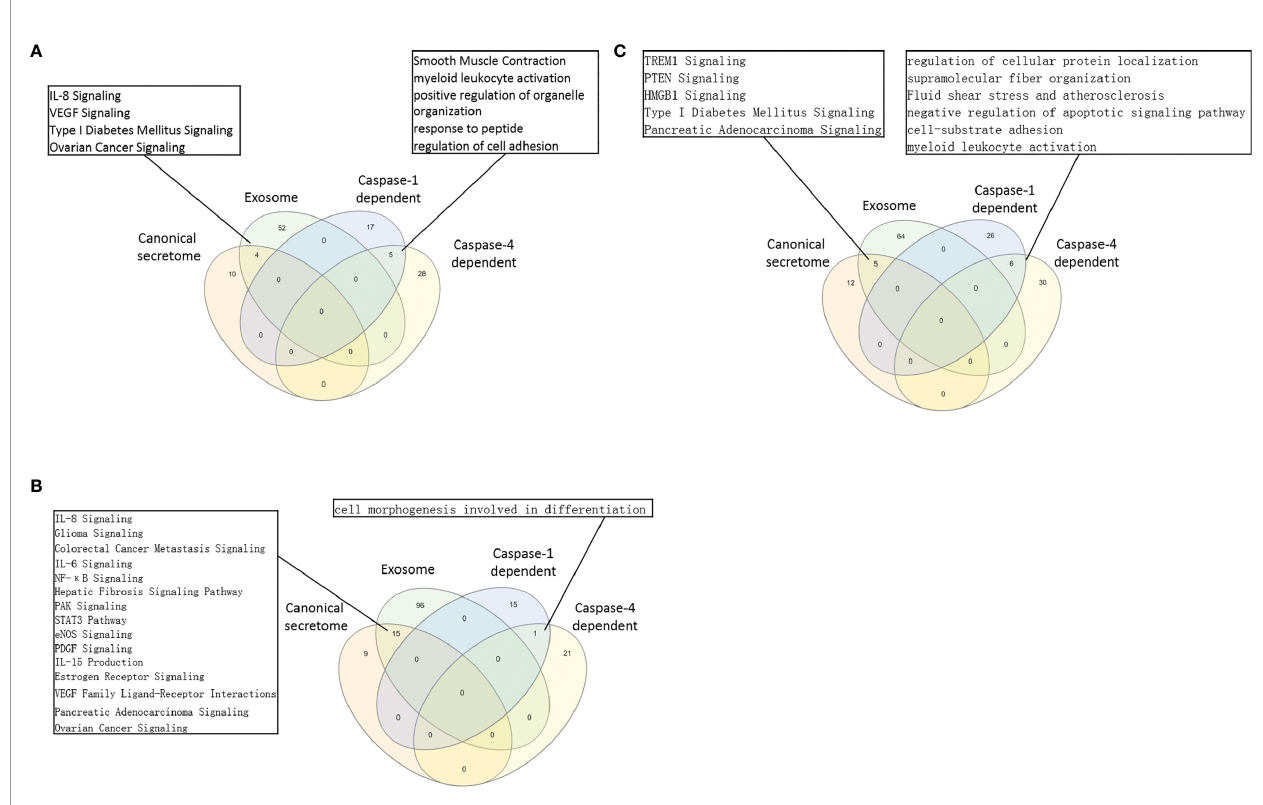
FIGURE 5 | (A) In normal tissue Treg groups, 4 pathways were shared by Treg canonical secretomes and exosome secretomes. The 5 pathways in Treg groups were shared by caspase-1-dependent, and Caspase-4 dependent gasdermine-D secretomes. Canonical secretome, Exosome secretomes, Caspase-1-dependent and Caspase-4 dependent gasdermine-D pathways in normal spleen Treg and tissue Treg were analyzed by Venn diagram. The Treg canonical secretomes and Treg exosomes had 4 overlapped pathways. The caspase-1 dependent-gasdermin D secretomes and Caspase-4 dependent gasdermine-D secretomes had 5 overlapped pathways. (B) In benign disease tissue Treg groups, 15 pathways were shared by Treg canonical secretomes and Treg Exosome secretomes. Only one pathway was shared by Treg caspase-1-gasdermin D secretomes and Treg caspase-4 dependent gasdermine-D secretomes. (C) In malignant disease tissue Treg groups, 5 pathways were shared by Treg canonical secretomes and Treg Exosome secretomes. The 6 pathway was shared by Treg caspase-1-gasdermin D secretomes and Treg caspase-4 dependent gasdermine-D